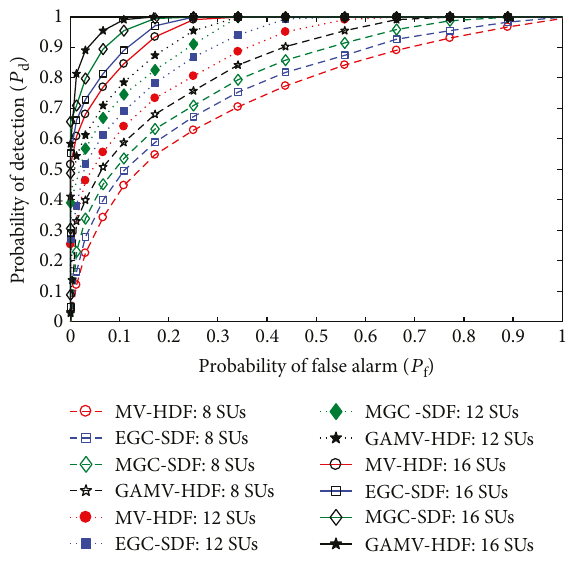
Figure 6: Probability of detection versus probability of false alarm at di ff erent ratios of cooperating SUs with MUs having low SNR compared with NSUs.